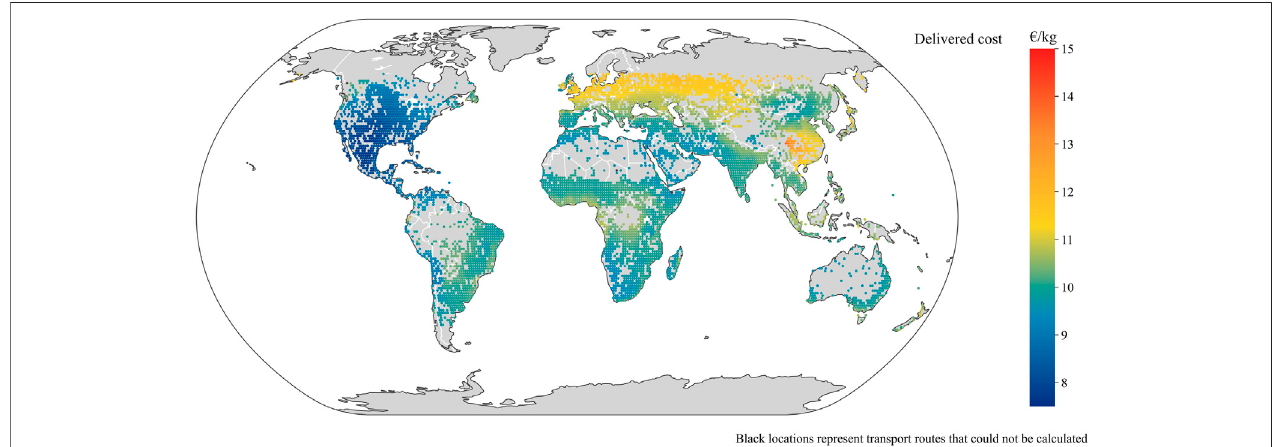
FIGURE15| Themostcost-effectivetransportmediumforH 2 requiredinCologne,Germany,forlargedemand(1,000 kt/y)andallowingpipelines,fromeachofthe 5970 selected global locations. Results are from a Monte Carlo simulation with 1,000 iterations.